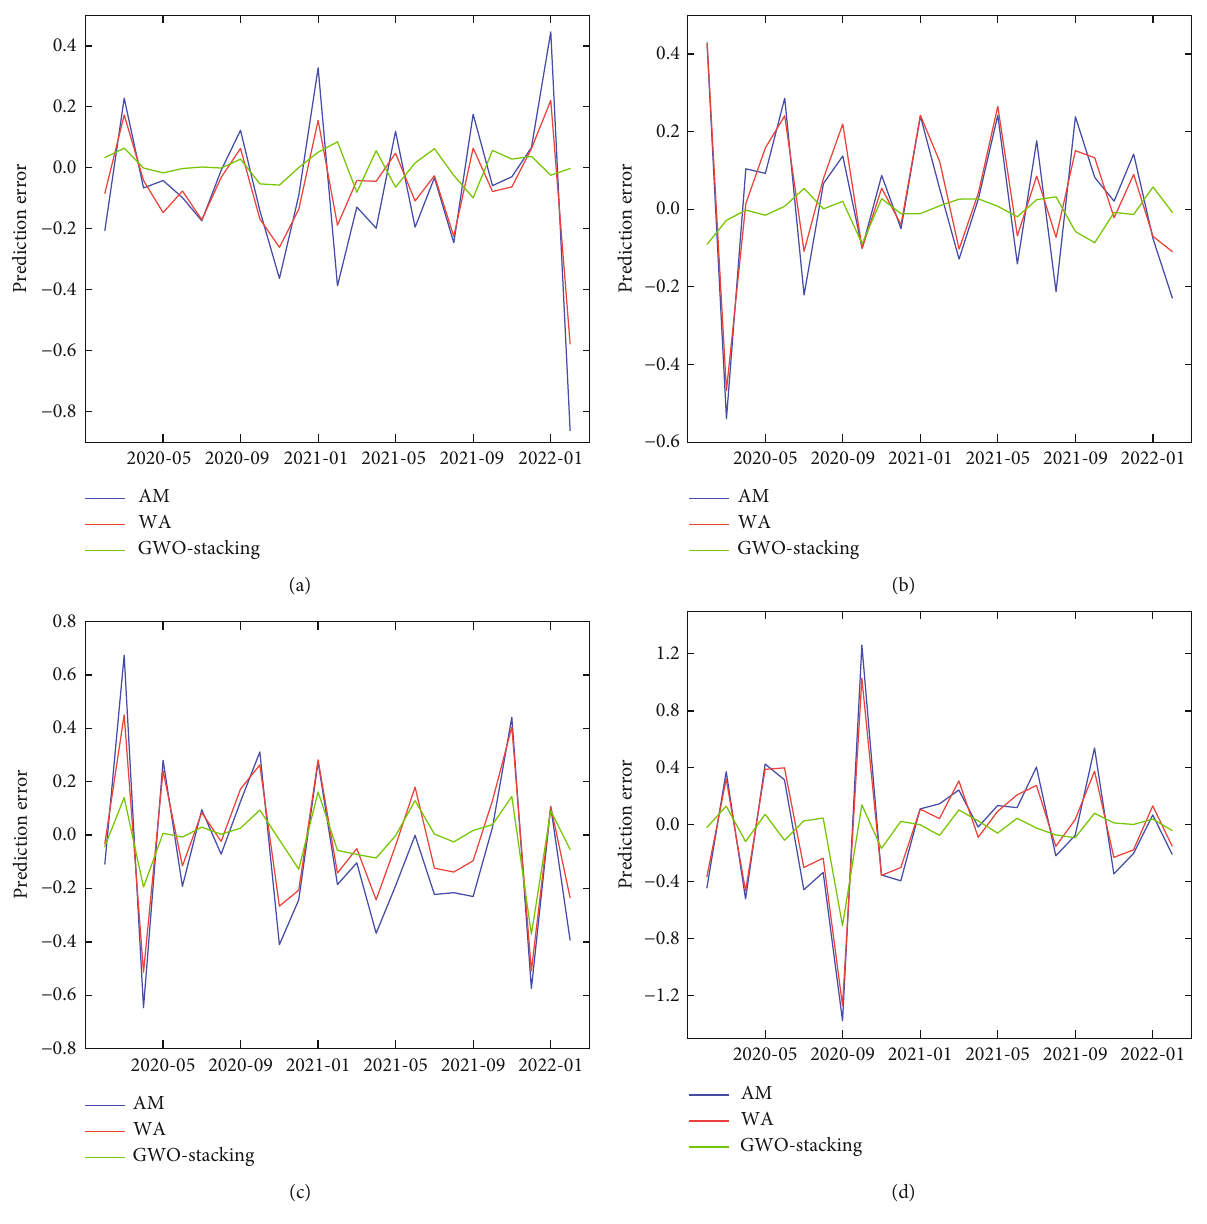
Figure 5: Comparison of prediction errors of three integration